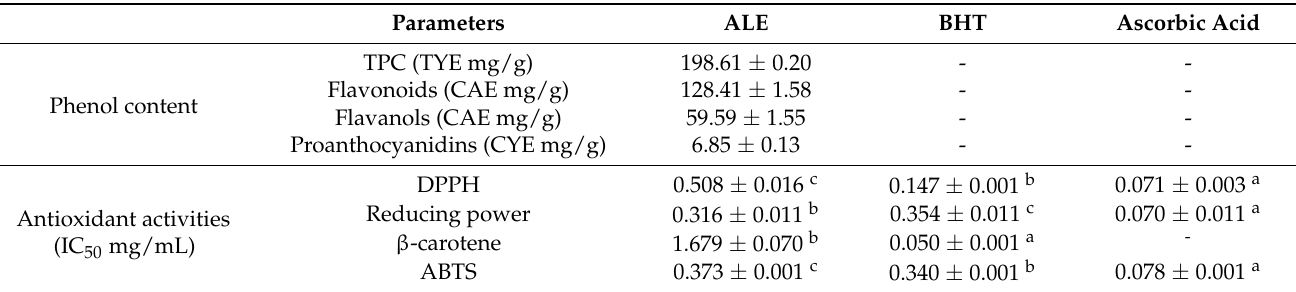
Table 1. Total phenol content and antioxidant activities of argan leaves extract (ALE) *. Parameters